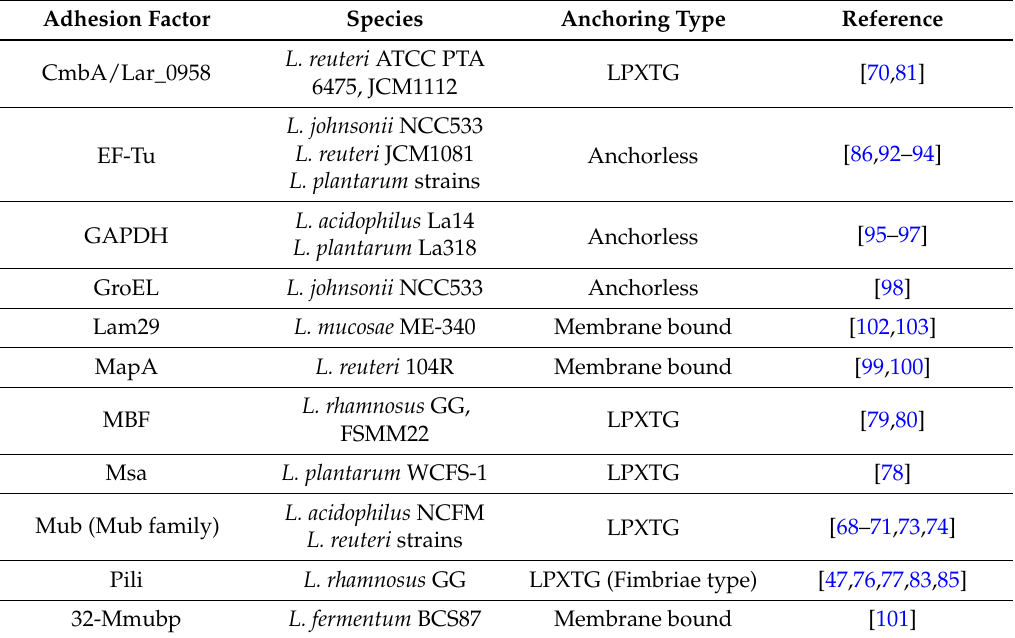
Table 1. Mucin adhesion factors in Lactobacillus